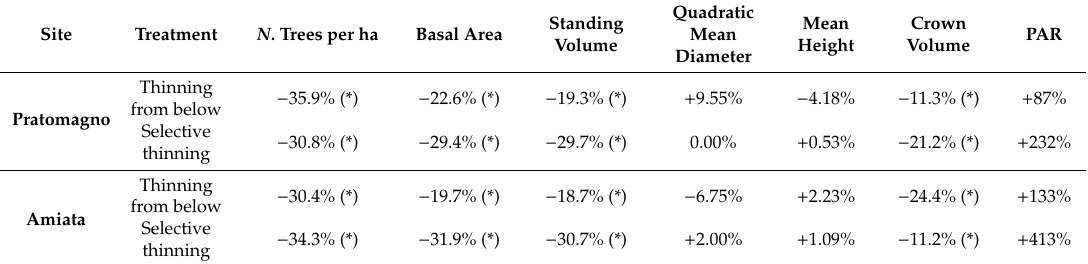
Table 1. E ff ects of silvicultural treatments for the main dendrometric and structural parameters in terms of percentage variations (* indicates statistically significant di ff erences in the Tukey’s Test with p -value below